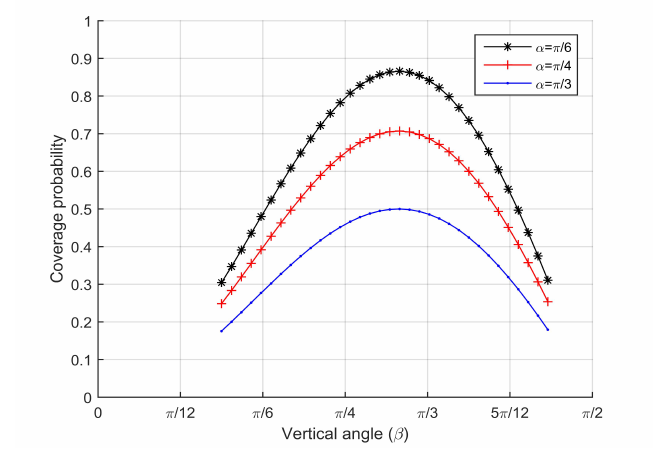
Figure 10. Coverage probability vs. the effective vertical angle for different effective horizontal